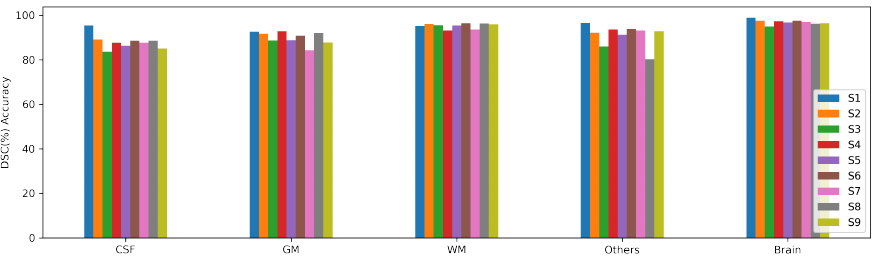
Figure 8. Accuracy per subject of our segmentation framework utilizing dice similarity coefficient (DSC(%)) metric.